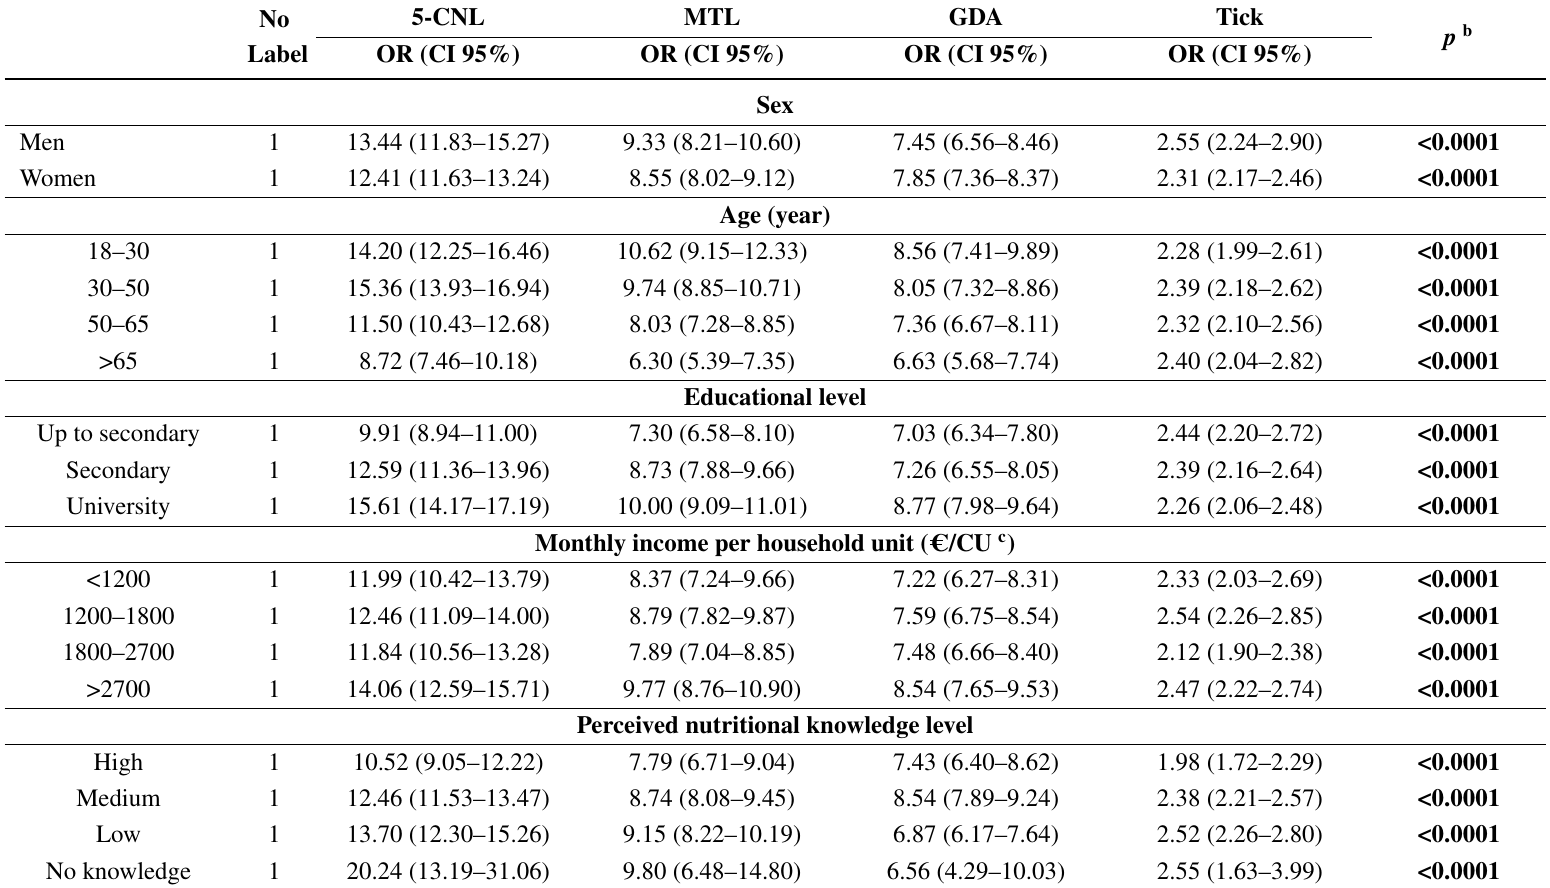
Table 3. Multivariate mixed model of the association between objective understanding and Front-of-Package labels, across subgroups at risk ( N = 14,230) a